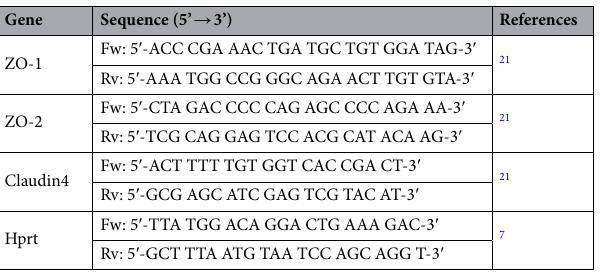
Table 1. Primers used in this study. Fw Represents sequences of a forward primer. Rv Represents sequences of a reverse